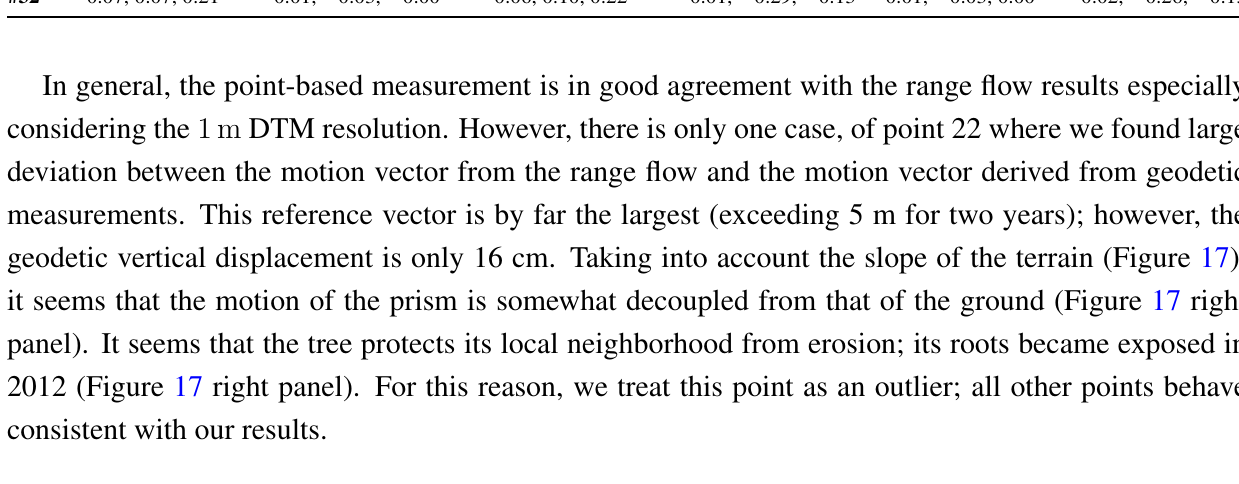
Figure 17. ( Left ) Picture of the target point 22, and its surrounding area; ( Right ) Profile of the terrestrial laser scanner (TLS) points from 2010 and 2012 at the location of target point